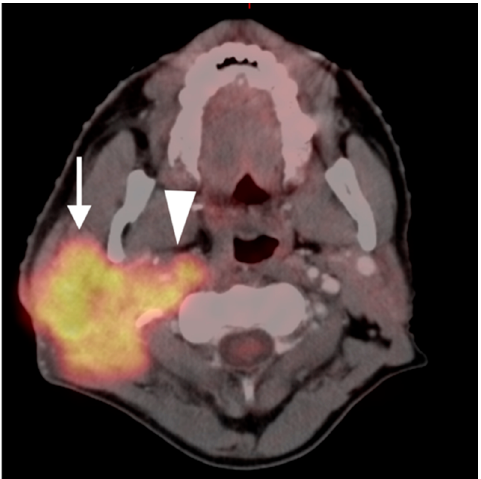
Figure 24. Non ‐ Hodgkin lymphoma of the right parotid gland. On this axial FDG PET ‐ CT image, diffuse large B ‐ cell lymphoma completely fills the superficial (white arrow) and deep (white arrowhead) lobes of the right parotid gland.